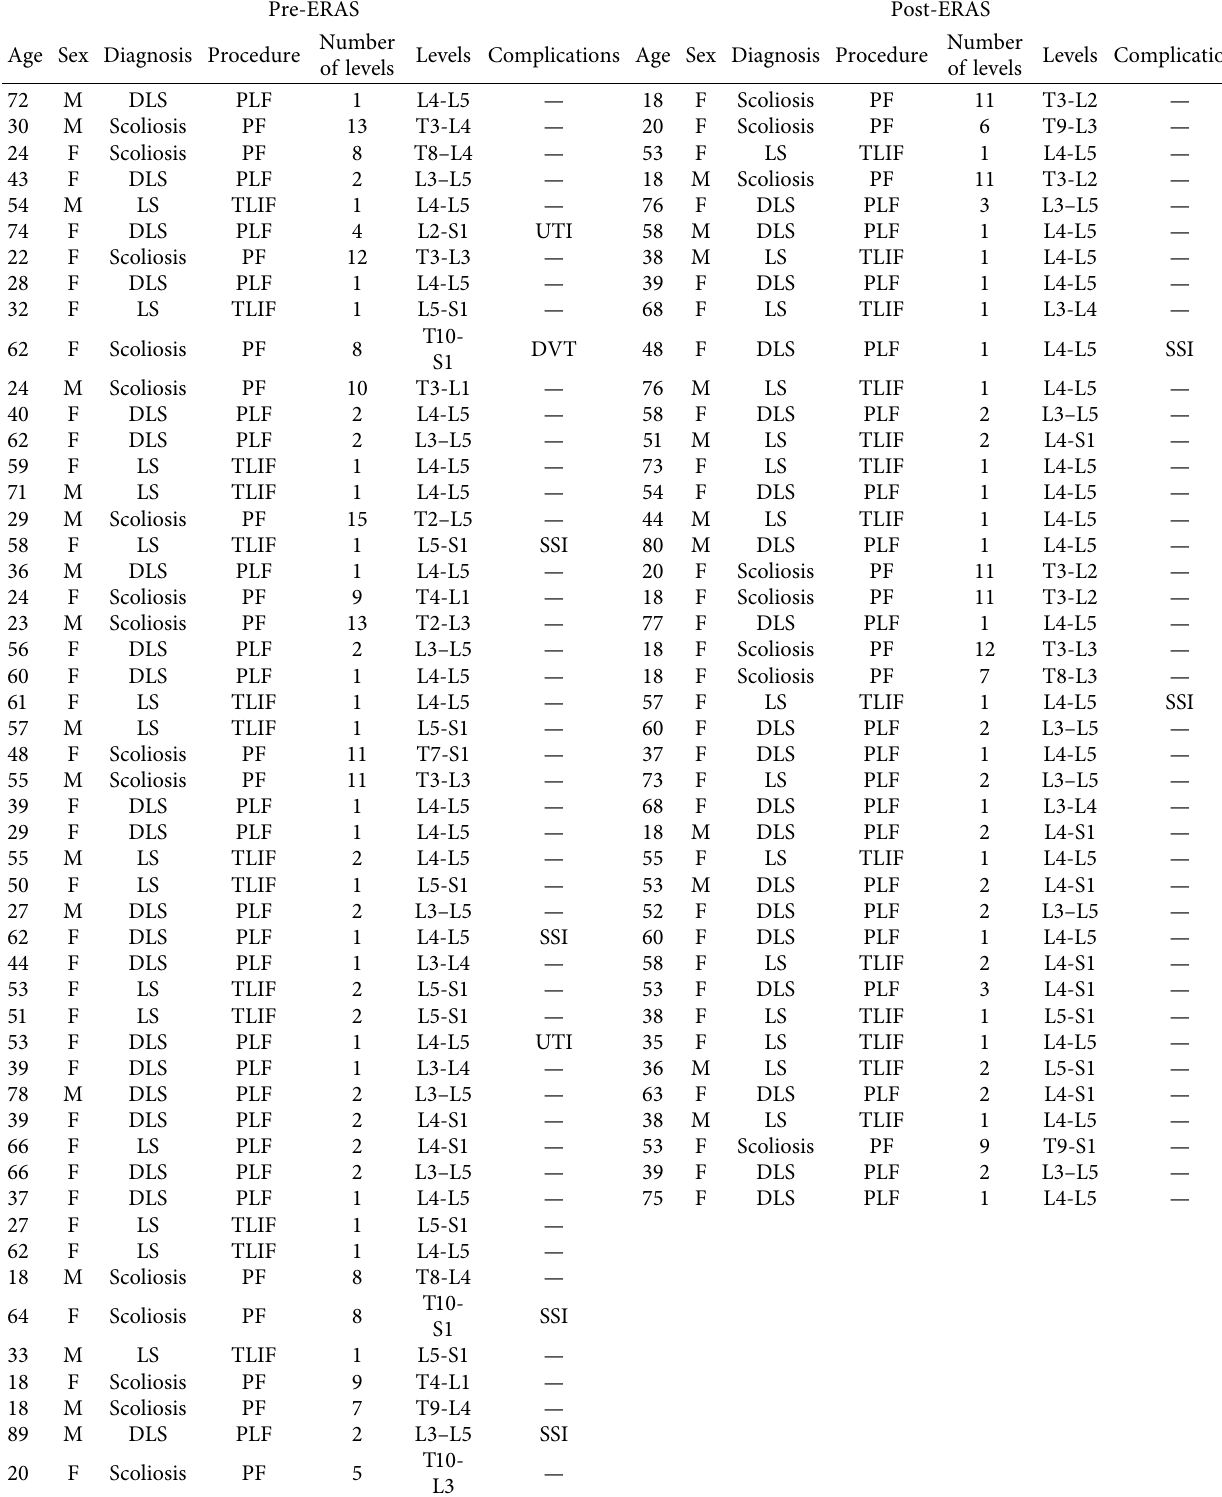
Table 3: Diagnosis and surgical management of all